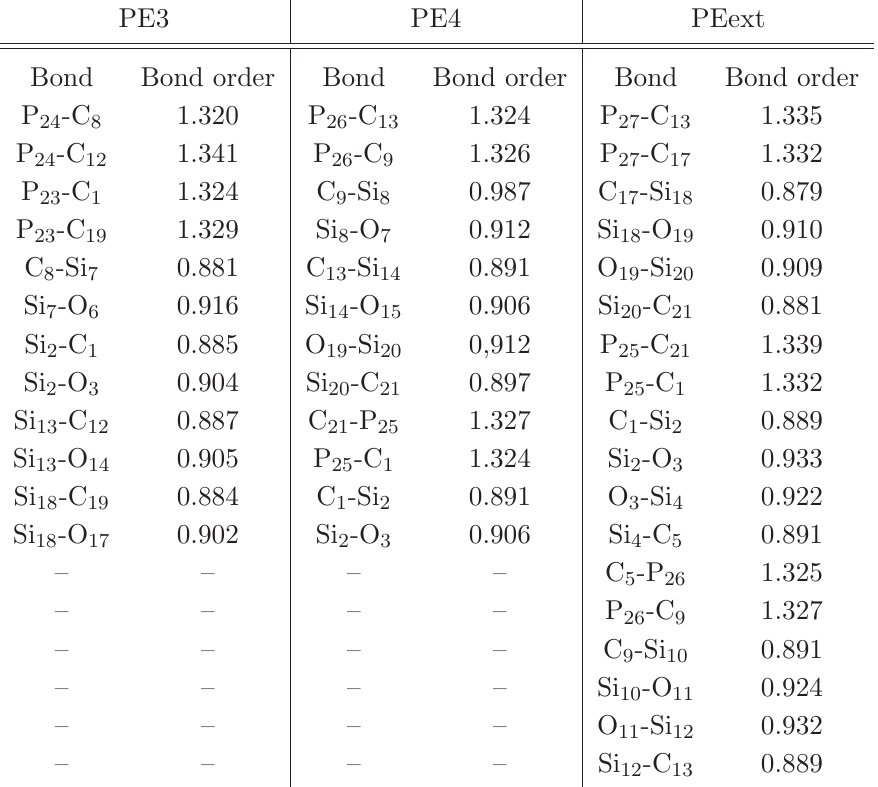
Table 9 Selected bond orders from phosphinine-ether macrocycles calculated with semiempirical PM3 method from MOPAC 6.0 program